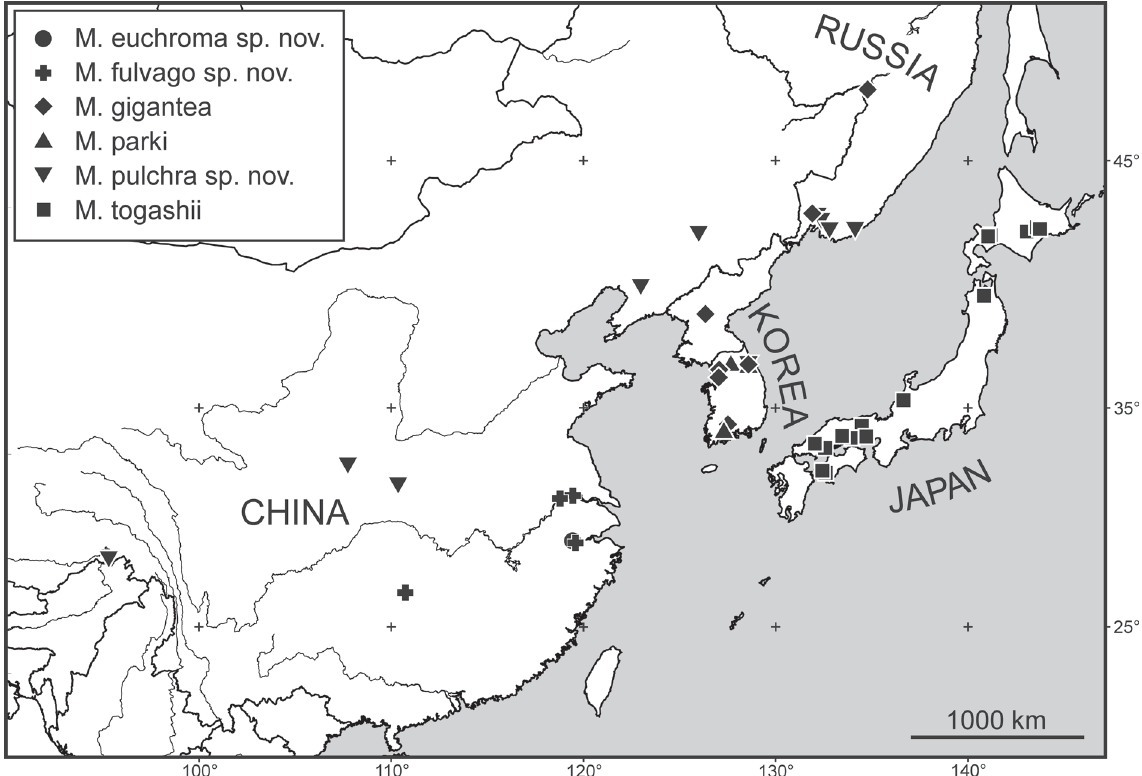
Fig. 14. Distribution of species of Megaxyela Ashmead, 1898 in East Asia. Records of M. togashii Shinohara, 1992 include reliable records published by Shinohara (1992, 2006), Tanaka (1999), Yamada (2000), Naito et al . (2004) and Shinohara et al. (2017). Other distribution data are based on examination of material in course of this